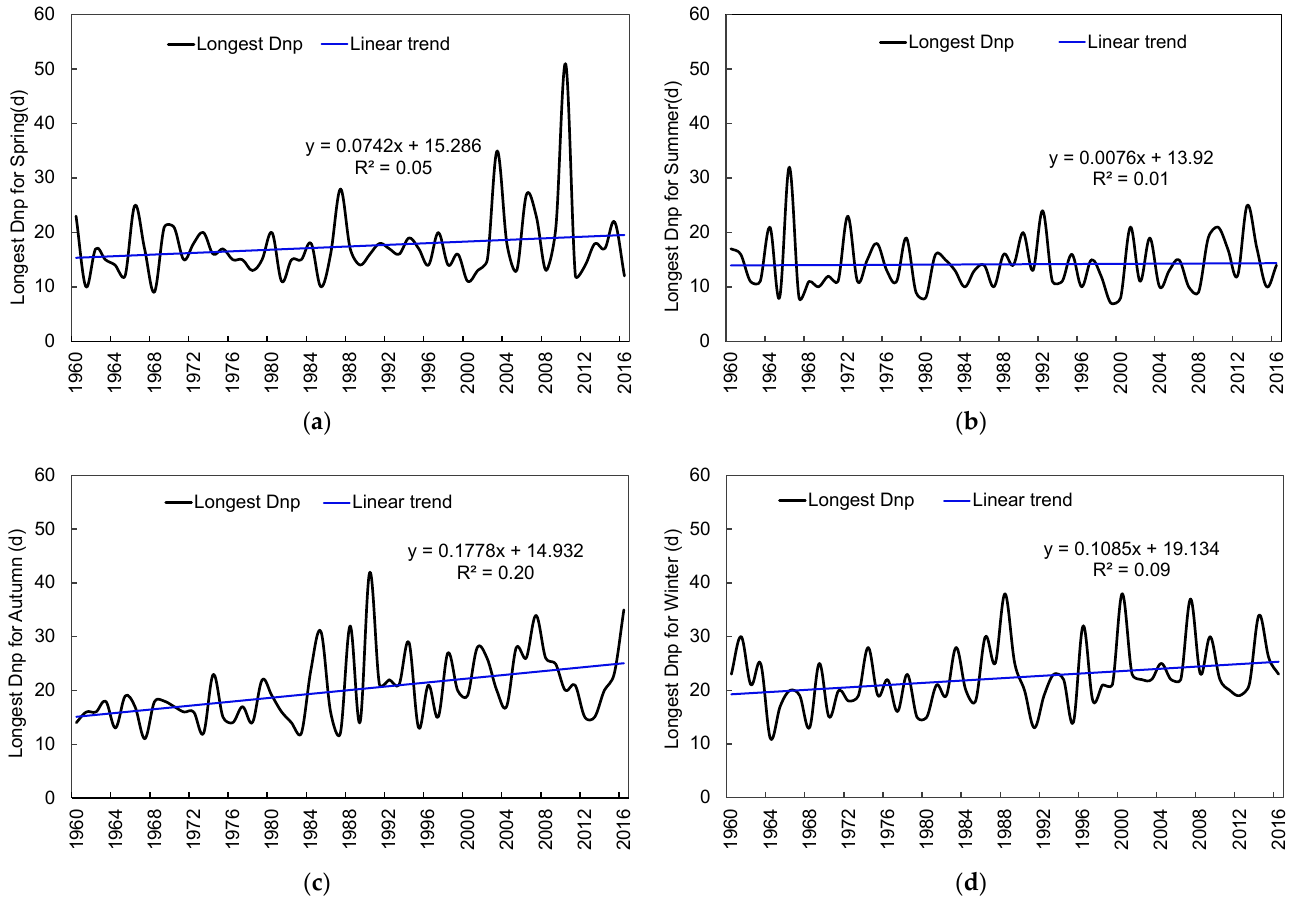
Figure 8. The temporal changes of seasonally longest Dnp in ( a ) spring, ( b ) summer, ( c ) autumn, ( d ) winter. Compared with Dnp values in spring and summer, those in fall and winter fluctuated much more. The longest Dnp values were 42 days in autumn and 38 days in winter, while the shortest Dnp were 11 days in autumn and 11 days in winter, respectively. For the Dnp values exceeding 30 days, most of them appeared since 1980. There were 5 times in autumn since 1980s and 7 times in winter since the 1980s among the total number of 8. As to the longest Dnp that were longer than 30 days and have occurred since 2000, there were 2 in spring (out of a total of 2, hence both since 2000); 2 in autumn (among a total of 5); and 4 in winter (among a total of 8). The droughts in Guizhou province have intensified since the 1980s, and the more obvious increasing trend of droughts in the 21st century have tended to aggravate harm to people in Guizhou. This finding is consistent with the previous research [24]. The increase in the spring and summer season was not that obvious. Once large values of Dnp occur in spring or summer, which will do severe harm to the crops, causing irreparable damage to agricultural production. For example, a large drought event happened in 2009–2010 in which 73 counties in Guizhou province suffered extra-severe to extreme drought, and the direct economic losses due to this disaster were up to 13.999 billion Chinese Yuan. The spatial distribution of the 2009–2010 southwestern drought was similar to that of the longest